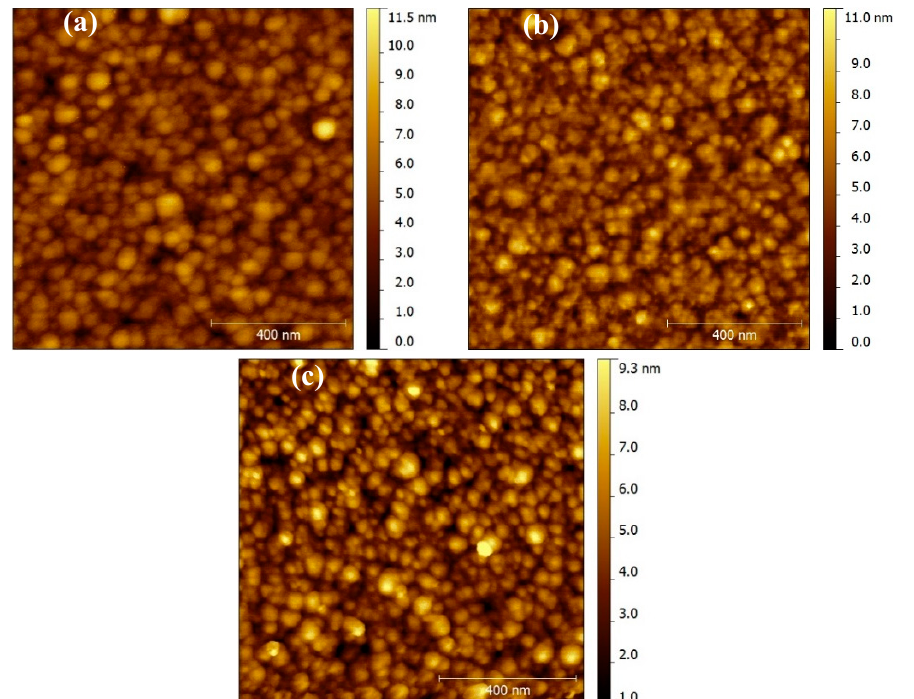
Figure 5. Atomic force microscope (AFM) surface topography of plasma enhanced chemical vapor deposition (PECVD) silicon thin films: ( a ) as-deposited; ( b ) furnace annealed at 650 °C; and ( c ) flash lamp annealed.